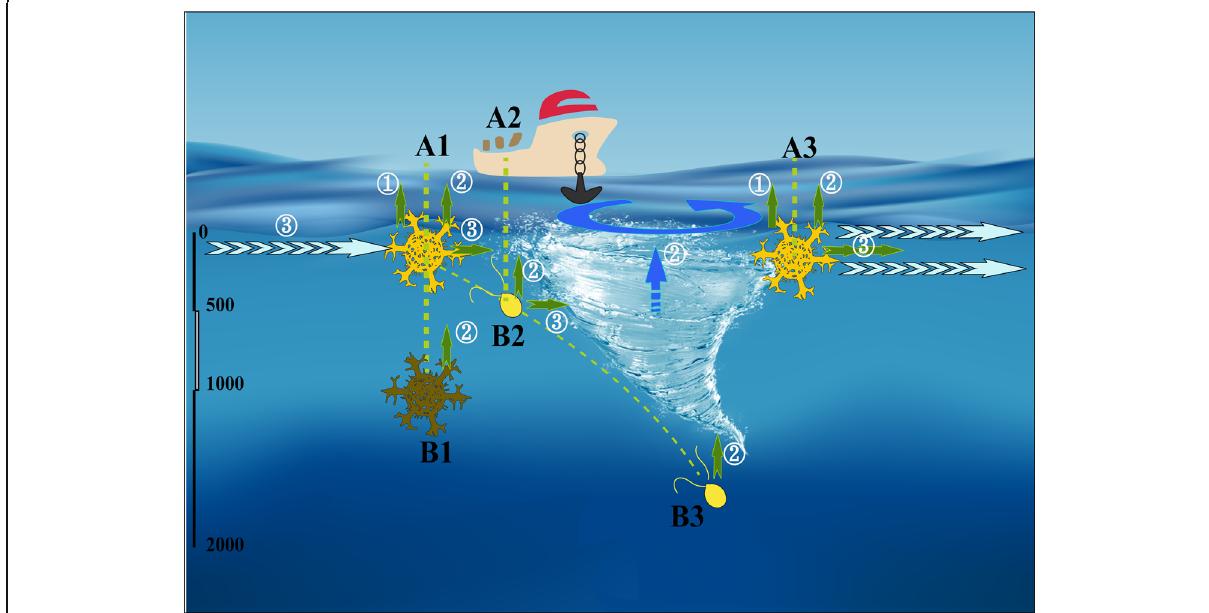
Fig. 5 Diagram showing a model based on the hypothesis that “ pico-sized radiolarians ” represent radiolarian gametes. Three kinds of movement in the ocean should be considered: ① the daily migration of nektons between 0 and 500 m; ② vertical movement of water masses with cyclonic eddies; ③ pacific circulation. We show a case in which cyclonic eddies occurred at a sampling site (night in the Northern Hemisphere), with cyclonic eddies enhancing the looping path, and increasing the distance between mother cells and